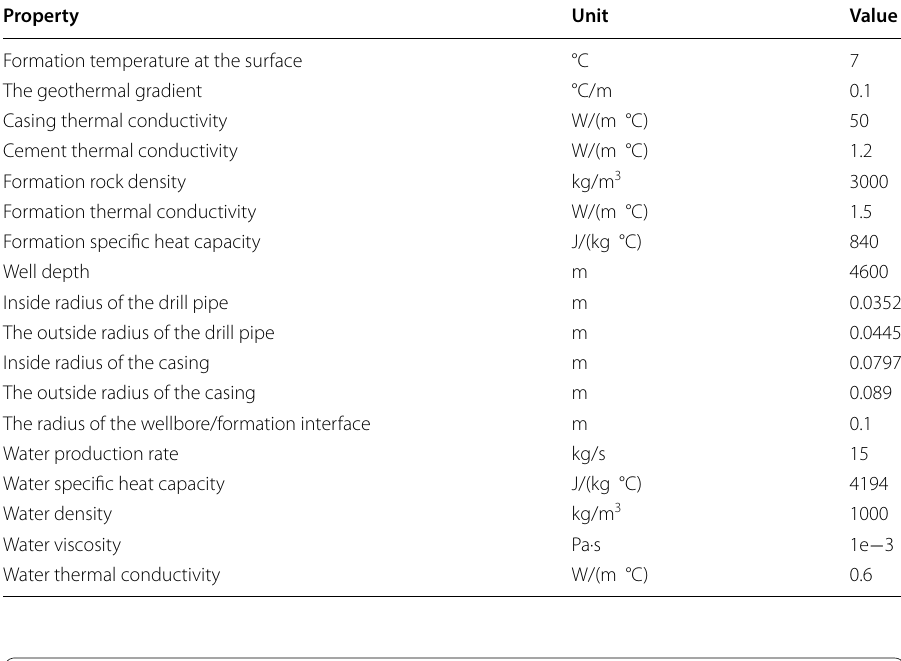
Table 4 Geometric parameters and material properties used in the simulation of the counterflow heat exchange model